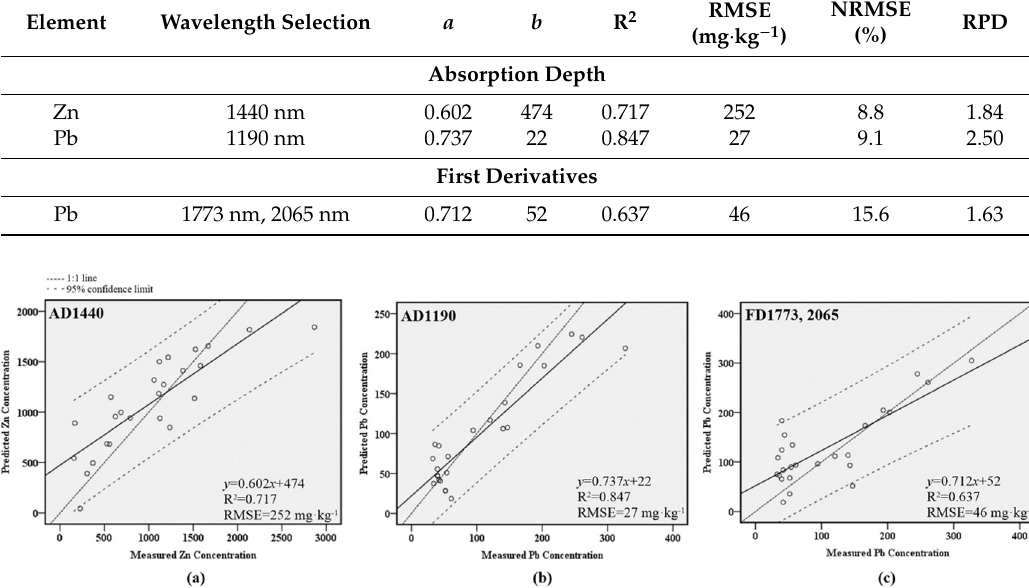
Table 7. Parameter for fitting measured heavy metal concentration to the predicted heavy metal concentration using a linear equation ( y = ax + b ) for validation models of Group B.